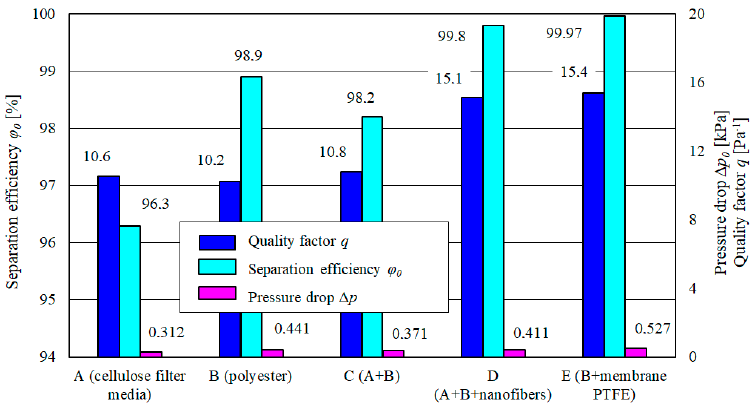
Figure 15. Separation efficiency of the tested filter media A, B, C, D and E.